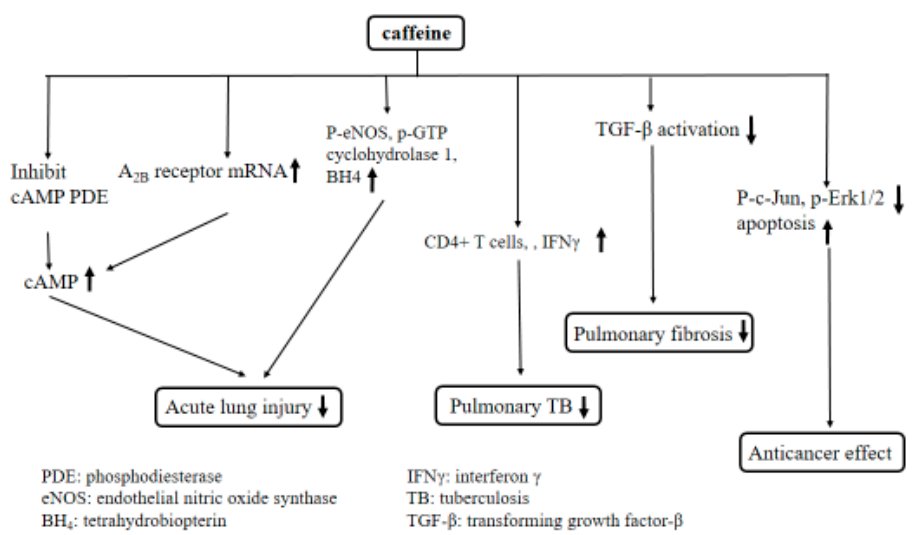
Figure 4. The postulated mechanisms regarding the effect of caffeine on the